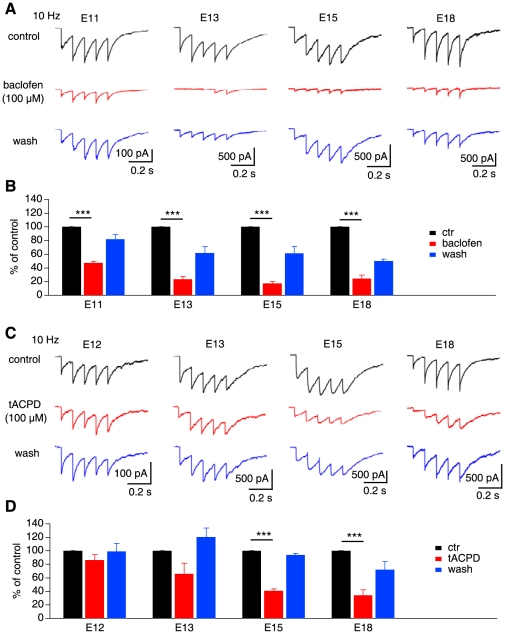
Modulation of GABAergic transmission in NL neurons by autoreceptors emerges prior to that by heteroreceptors.
A, Effects of GABABR agonist baclofen (100 µM) on IPSCs of NL neurons obtained from chicken embryos ages of E11, E13, E15, and E18. Inhibition of the IPSCs by baclofen was observed in all cells. B, Summary data showing that baclofen (100 µM) reduced IPSCs significantly in all ages tested (n = 6, 7, 7, and 5 for E11, E13, E15, and E18, respectively). C, Effects of mGluR agonist tACPD (100 µM) on IPSCs of NL neurons obtained from chicken embryos ages of E12, E13, E15, and E18. D, Significant suppression of IPSCs by tACPD (100 µM) was detected in E15 and E18 but not at E12 or E13 (n = 6, 5, 8, and 7 for E12, E13, E15, and E18, respectively). In this and subsequent figures, bars represent means ± SEM. NS: not significant (p>0.05), *p<0.05, **p<0.01, and ***p<0.001 (ANOVA post hoc Fisher's test).